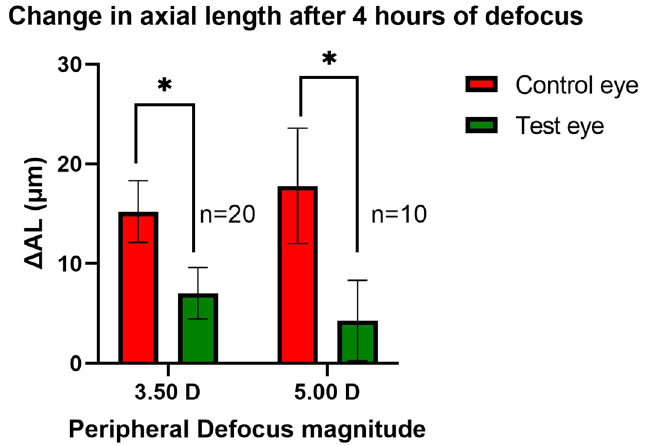
Figure 2. Axial length changes (mean ± SEM) following 4 h of peripheral defocus sessions. Note: *Represent significant differences between test eyes and controlled eyes with corrected p < 0.05.